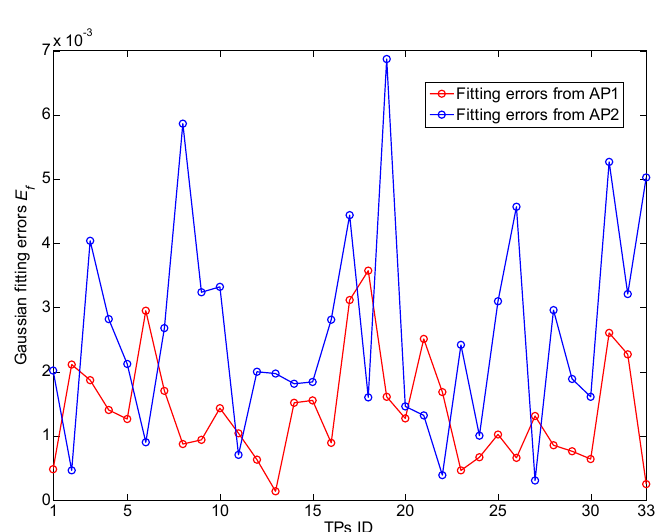
Figure 14. Gaussian fitting errors at